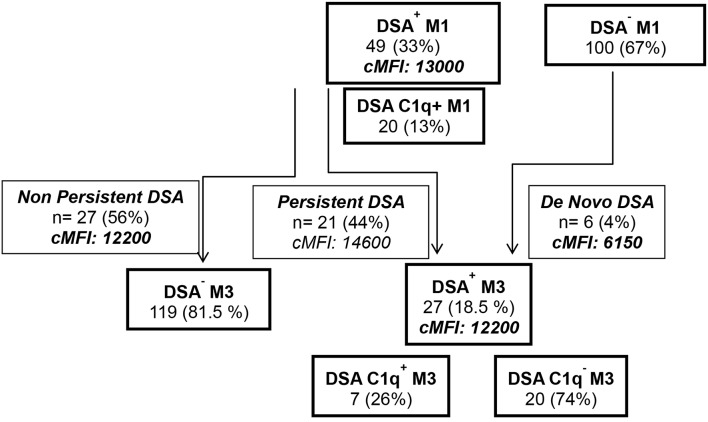
Study flow chart analysis of the detection by single antigen flow bead Luminex Assay of de novo DSA and C1q binding activity of DSA at M1 and at M3 post-LTx.